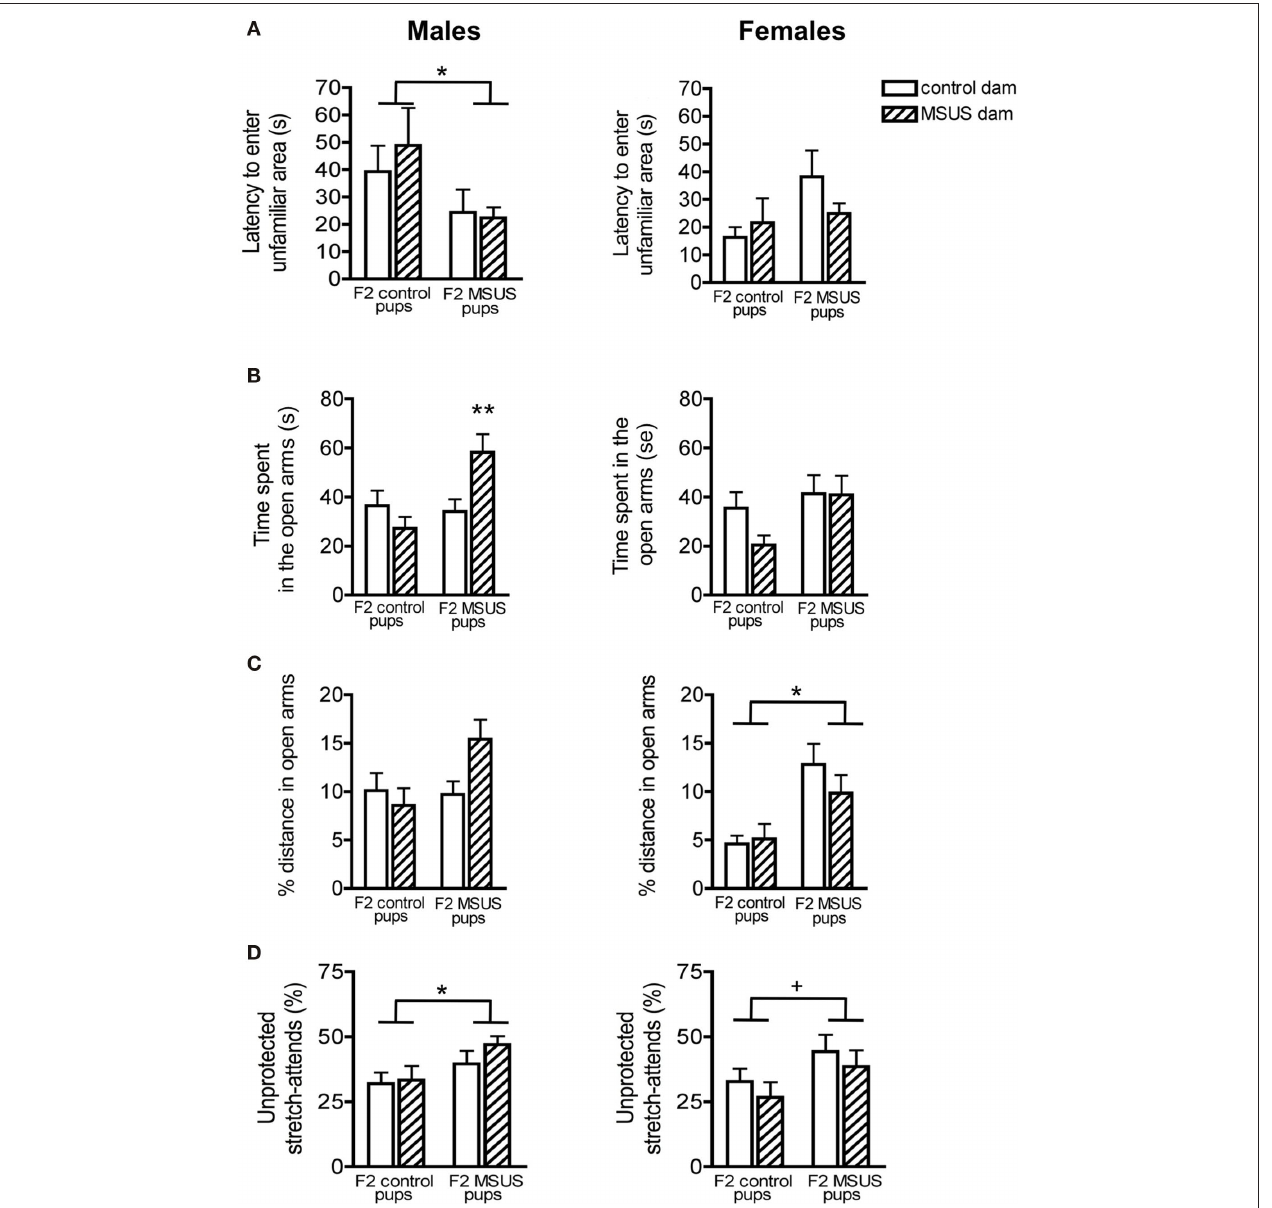
MSUS females also covered a greater proportion of total distance in the open arms, irrespective of the treatment received by their dam. (D) F 2 MSUS mice had a greater proportion of stretch attends from an unprotected area than control mice, irrespective of the treatment received by the dam that reared them. A strong trend for similar behavioral alterations was observed in F 2 MSUS females when compared to control. Control pups raised by biological dam, males n = 20, females n = 16; MSUS pups raised with biological dam, males n = 18, females n = 14; control pups raised by MSUS dam, males n = 14, females n = 15; MSUS pups raised with control dam, males n = 11, females n = 16. 0.05 <+< 0.1; * p < 0.05; ** p < 0.01. Bar graphs represent mean values ±